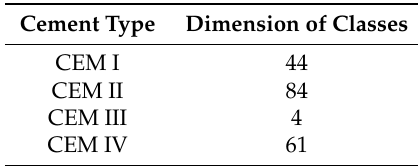
Table 8. Dimensions of datasets related to each type of cement.